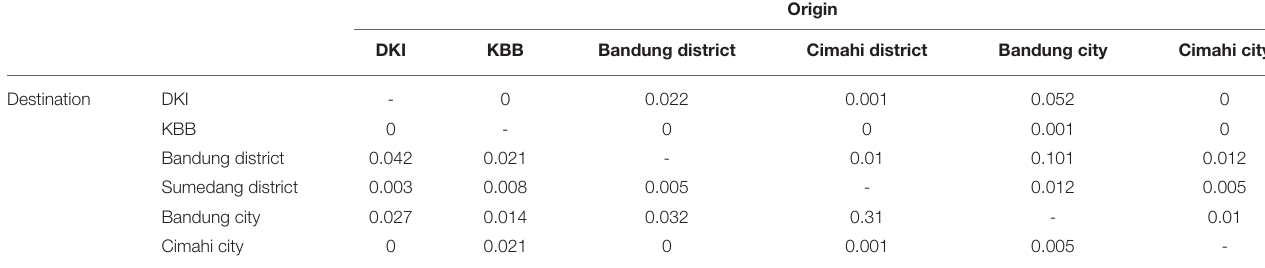
TABLE 4 | Estimated OD matrix in Jabaraya (district/city